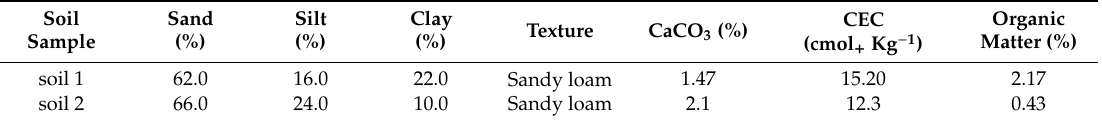
Table 1. Texture analysis, organic matter (%), content of CaCO 3 (%) and cation exchange capacity (CEC) for the two soils used.